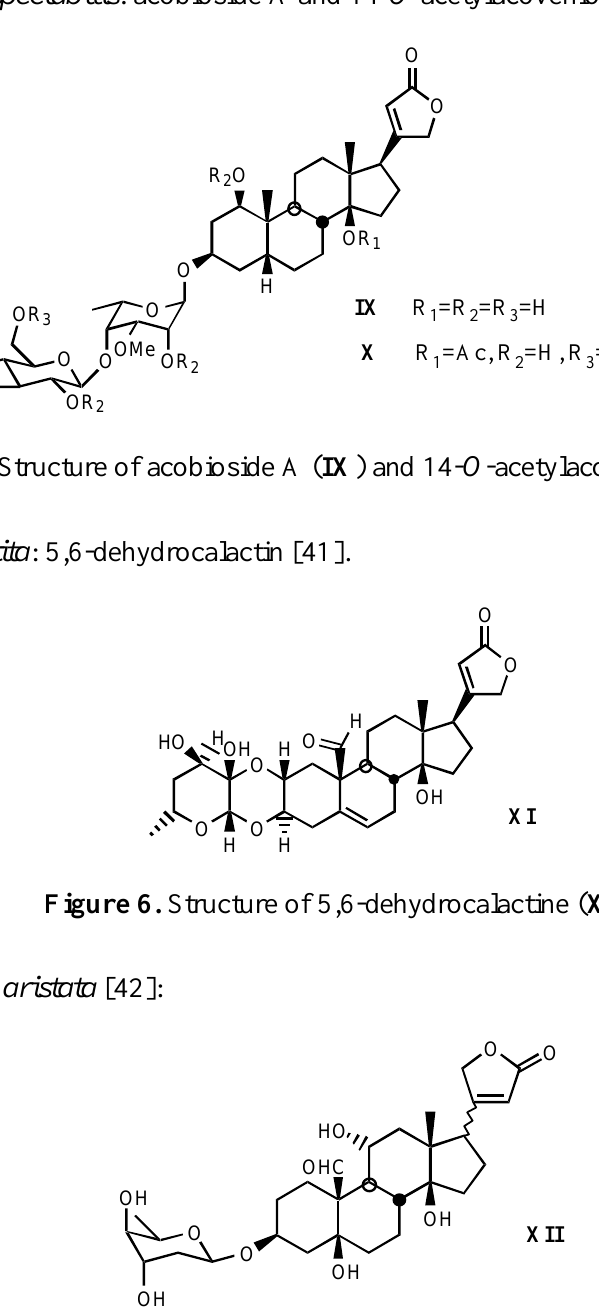
Figure 7. Digitalis-like glycoside with cardiotonic activity isolated from Nierembergia aristata ( XII